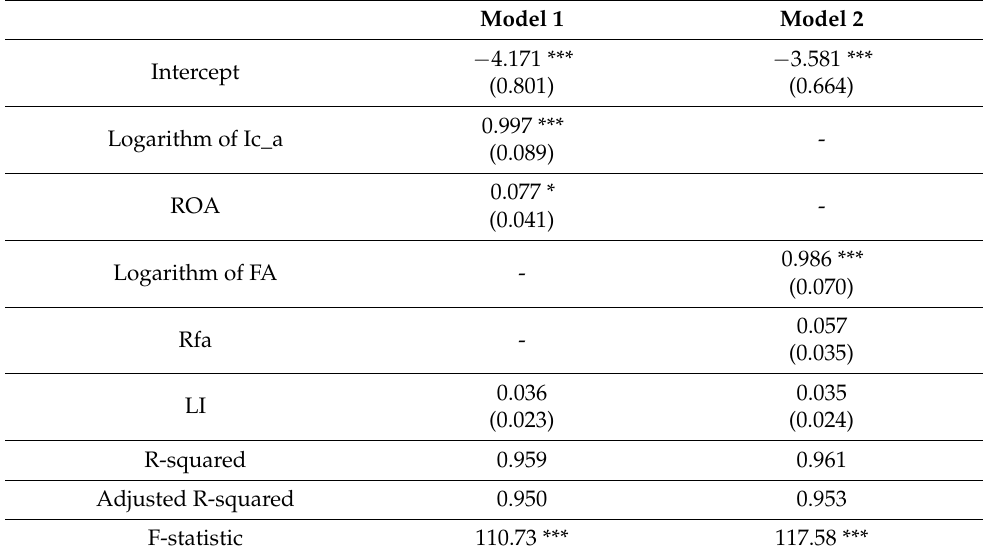
Table 6. Regression